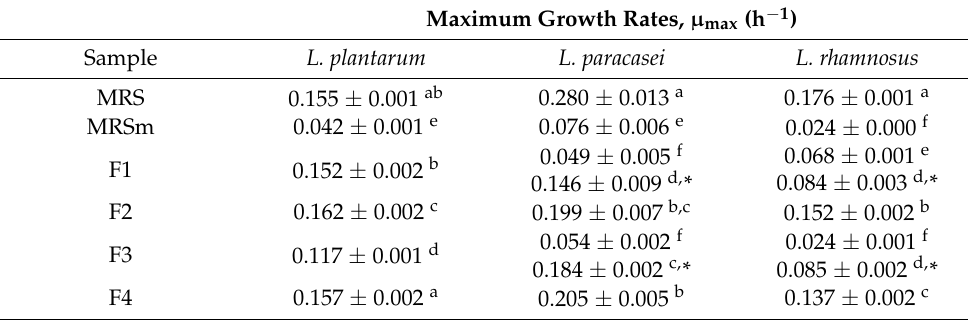
Table 2. Maximum growth rates for Lactobacillus